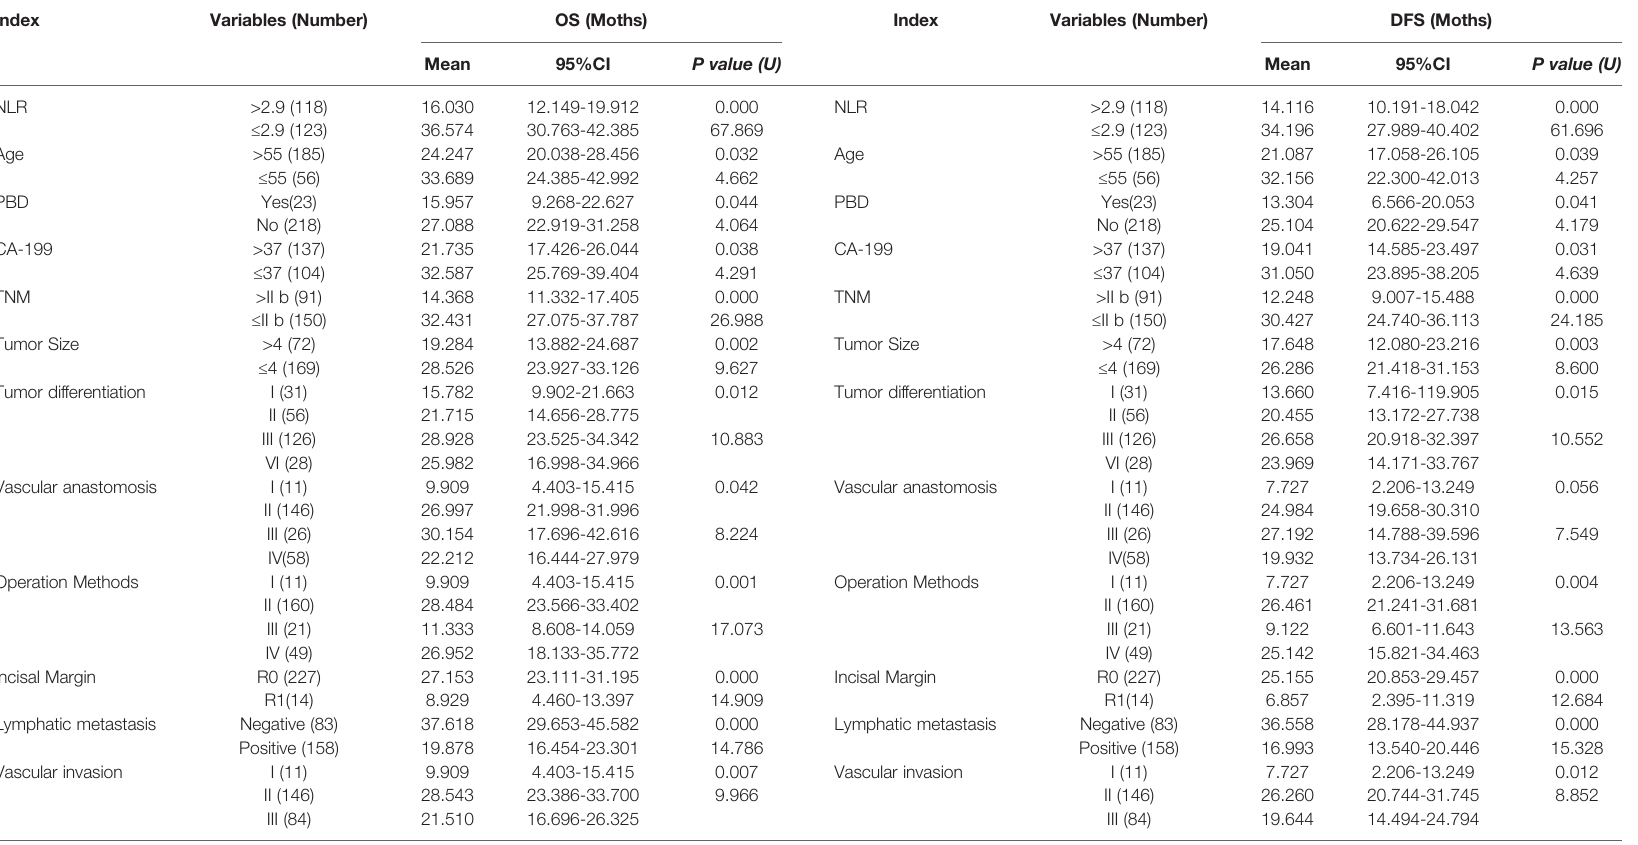
TABLE 2 | Univariate Analysis of risk factors for tumor recurrence and long-term survival in patients with